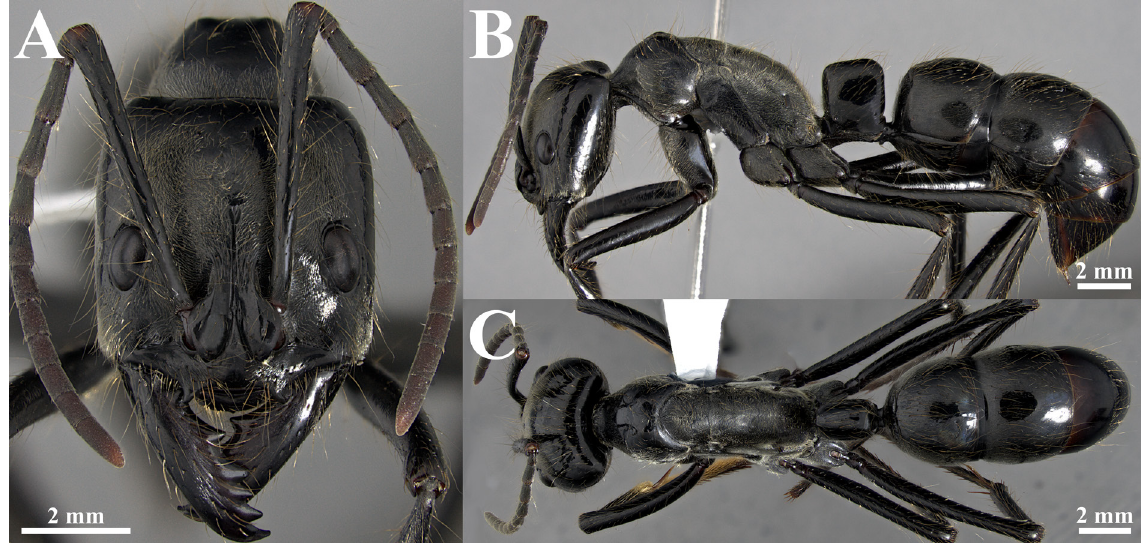
(specimen from Juara, Mato Grosso, Brazil; DZUP 549809). Fig. 23. Dinoponera mutica Emery, 1901, ☿ A . Full-face view. B . Full body in lateral view. C . Full body in dorsal